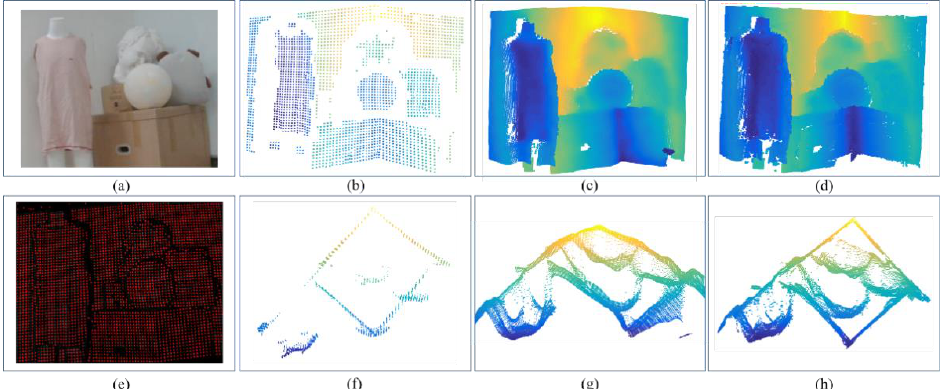
Figure 13. Reconstruction results of complex scenes. ( a ) the target scene, ( e ) detected corner by DCSL; Point clouds by ( b ) DCSL, ( c ) TOF, ( d ) the proposed method, and the side view of point clouds by ( f ) DCSL, ( g ) TOF, ( h ) the proposed method respectively.